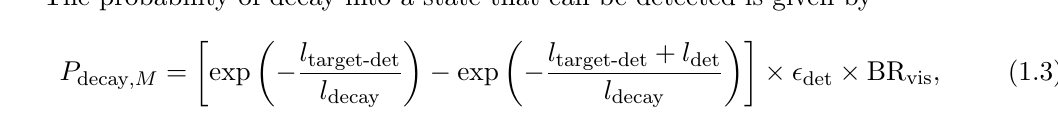
Figure 1 . A typical cigar-like shape of the sensitiviy region of Intensity Frontier experiments. The upper boundary is determined by the condition l decay detector. The lower boundary of the sensitivity region is determined by the parameters at which decays become too